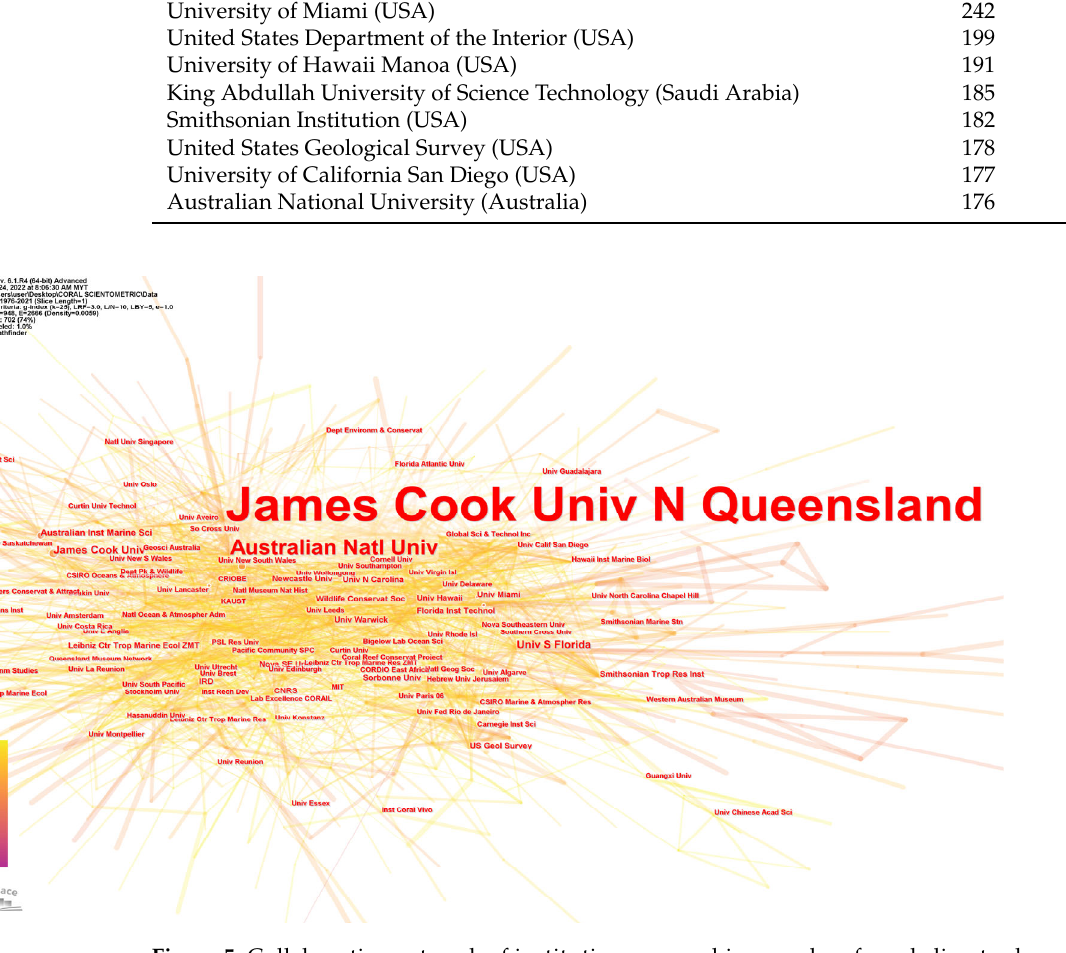
Figure 5. Collaborative network of institutions researching coral reefs and climate change from 1976 to 2021. Table 1. Top 20 institutions in the field of coral reef and climate change.